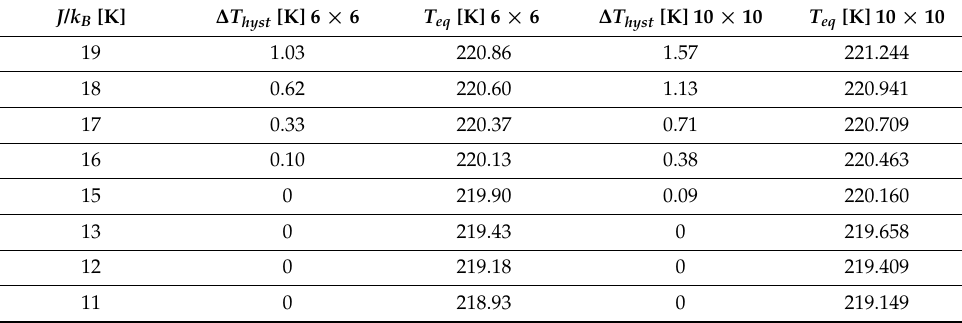
Table 3. Comparison of simulations for the 6 × 6 and 10 × 10